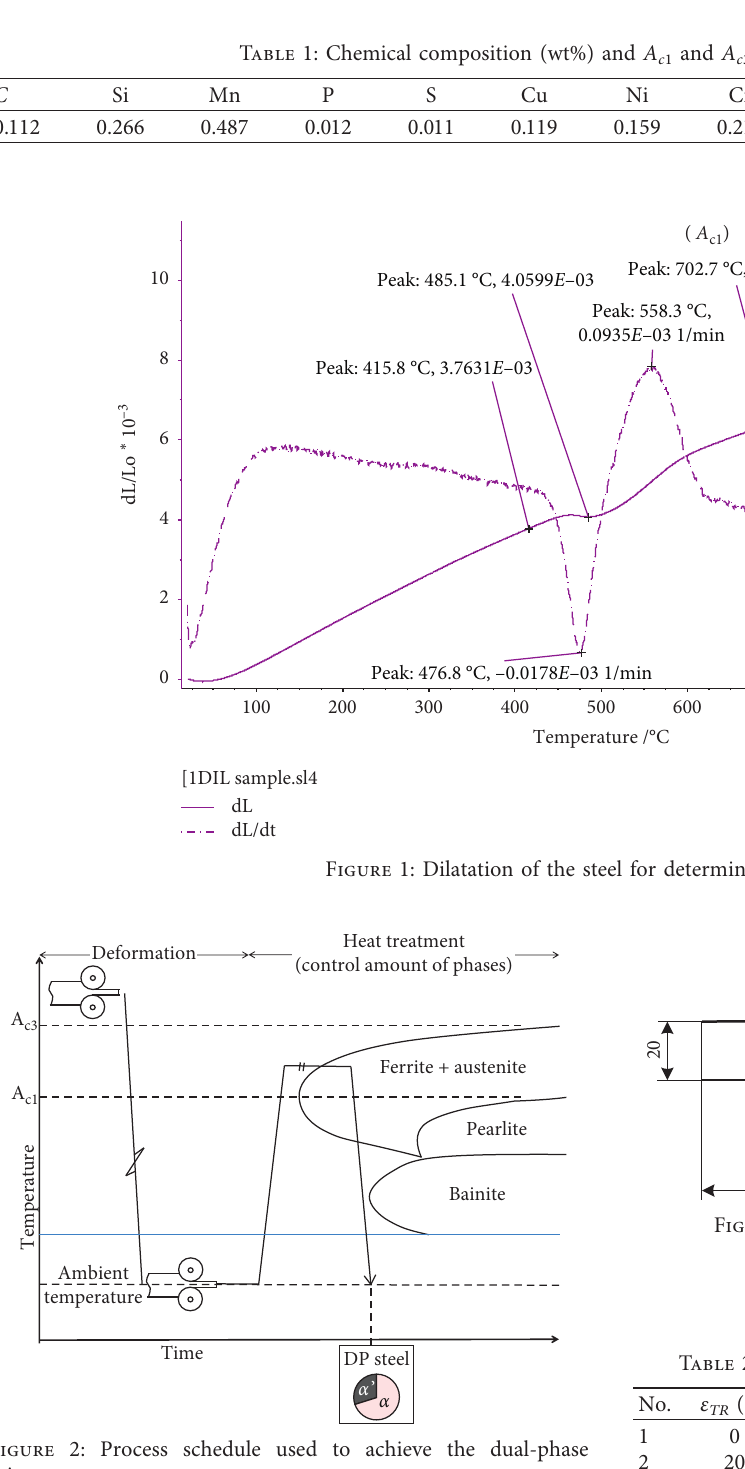
Figure 2: Process schedule used to achieve the dual-phase microstructure.